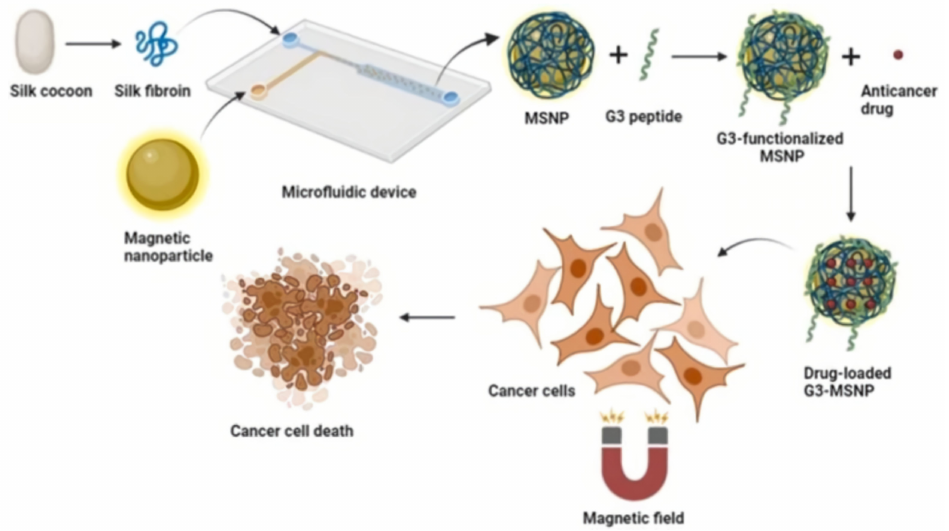
Figure 13. A schematic of peptide-functionalized magnetic silk nanoparticles produced by a swirl mixer for enhanced anticancer activity of ASC-J9. Reprinted from [111] with permission of Elsevier provided by Copyright Clearance